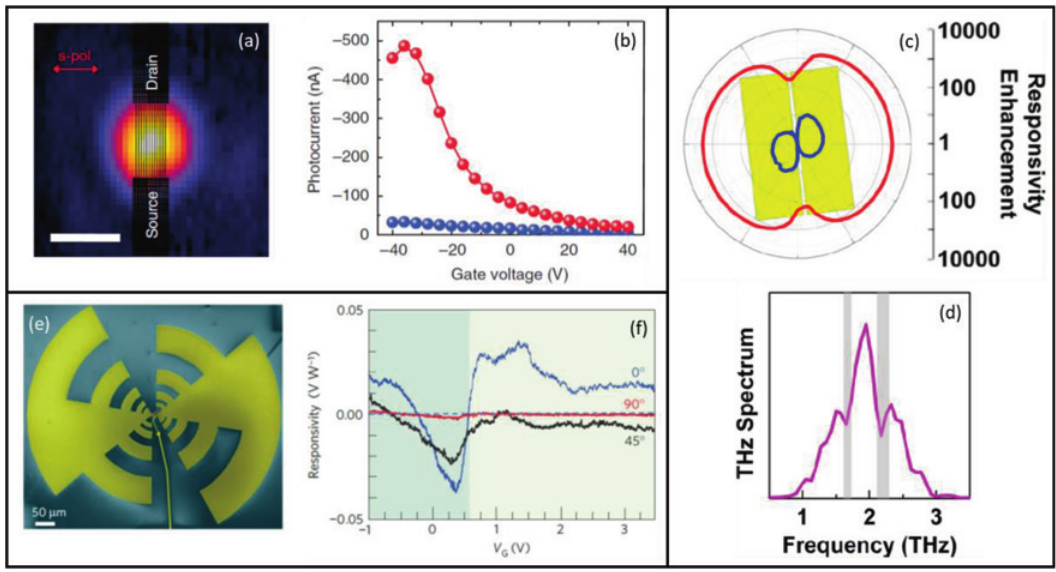
Figure 7: Graphene plasmonic photodetectors. (a) Scanning photocurrent image of a nanoribbon device designed for plasmon-enhanced photodetection near 10 μ m wavelength. The scale bar is 30 μ m. (b) Photocurrent versus gate voltage measured with the device of (a)